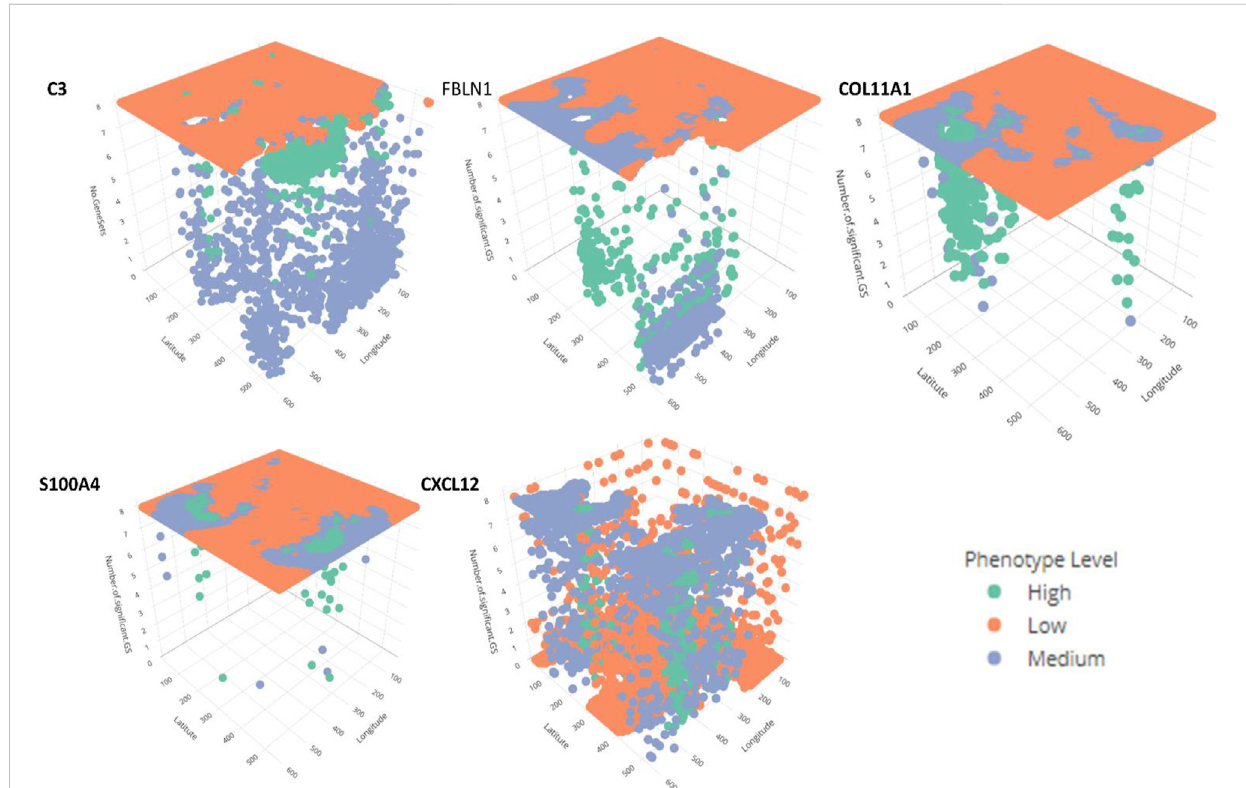
FIGURE 2 The interactive plots (3D) for the 5 phenotypes at Low, Medium and High CAF levels. Further information about the number and the name of signi fi cantgene-sets ateachlocationcanbeobtainedbyrotating,zooming,andclickingeachdot.Thegreen,orangeandbluedotsre fl ecthigh,low,and medium CAF levels. (This fi gure is an illustrative static snapshot of the interactive 3D plots accessible online at https://mortezahaji.github.io/GWLCT-